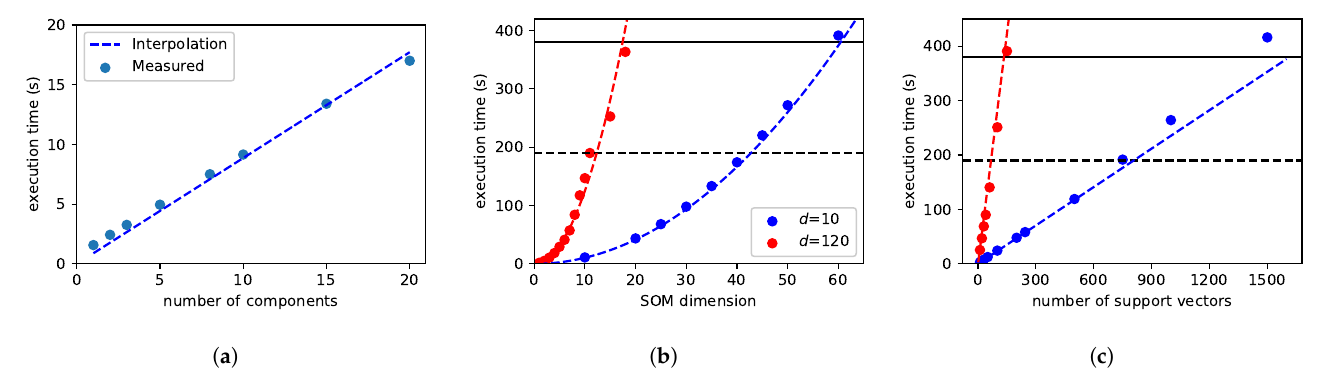
Figure 4. Execution time for PCA, SOM and SVM for a standard image with ( h , w ) = ( 956,684 ) . The ideal requirement and hard requirement on computational time are shown with dashed and solid lines respectively. ( a ) Execution time for PCA projection; ( b ) Execution time for the SOM method; ( c ) Execution time for